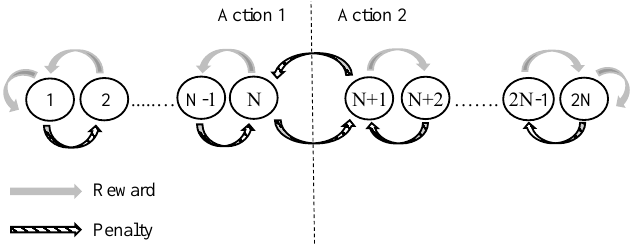
Figure 1. Transition graph of a two-action Tsetlin Automaton with 2N memory states. The Stochastic Searching on the Line (SSL) automaton pioneered by Oommen [45] is somewhat different from regular automata. The SSL automaton is an optimization scheme designed to find an unknown optimum location λ ∗ on a line, seeking a value between 0 to 1, [ 0, 1 ]